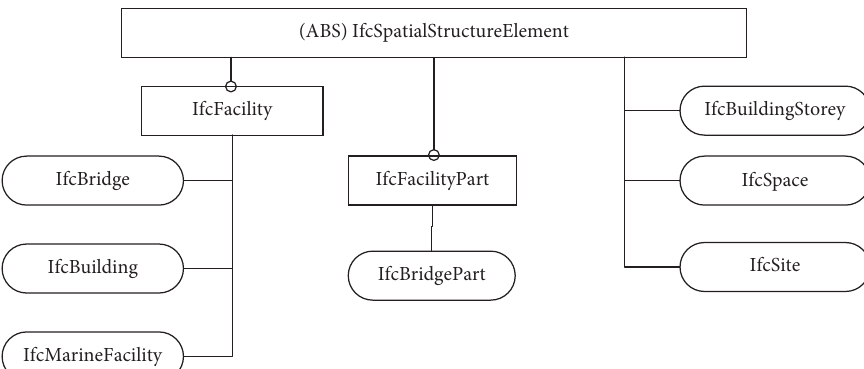
Figure 2: The shared spatial structure of IfcRail standard.